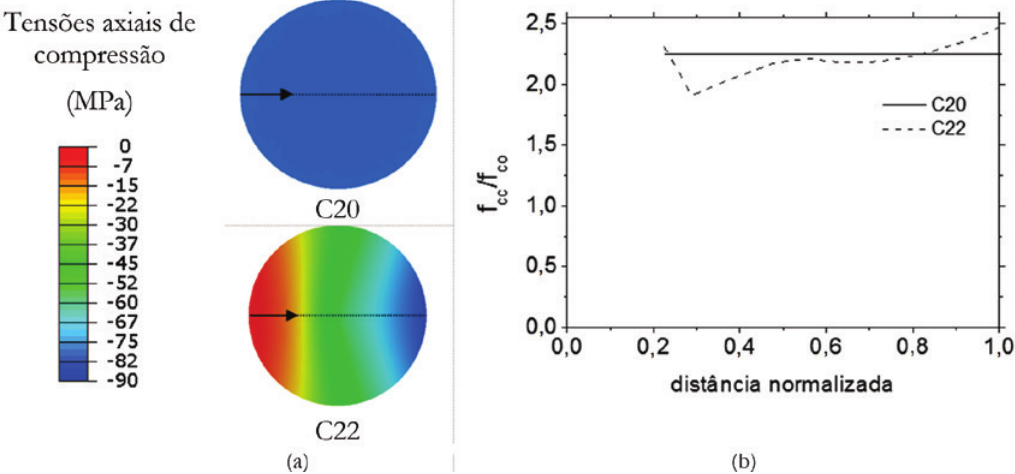
Figura 11 Tensões de compressão em pilares circulares C20 e C22 (Valores em MPa): (a) distribuição de tensões; (b) acréscimo de tensões nos trechos indicados em